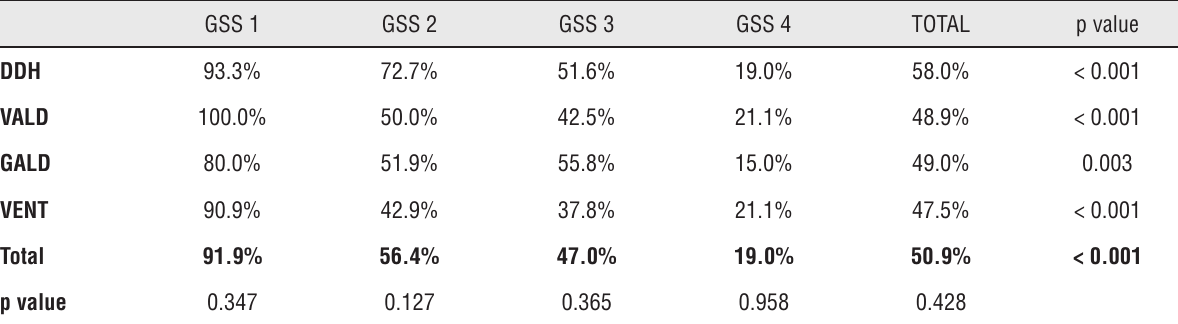
Table 3 - Success rate (RF ≤ 4mm) in each position according to Guy’s Stone Score